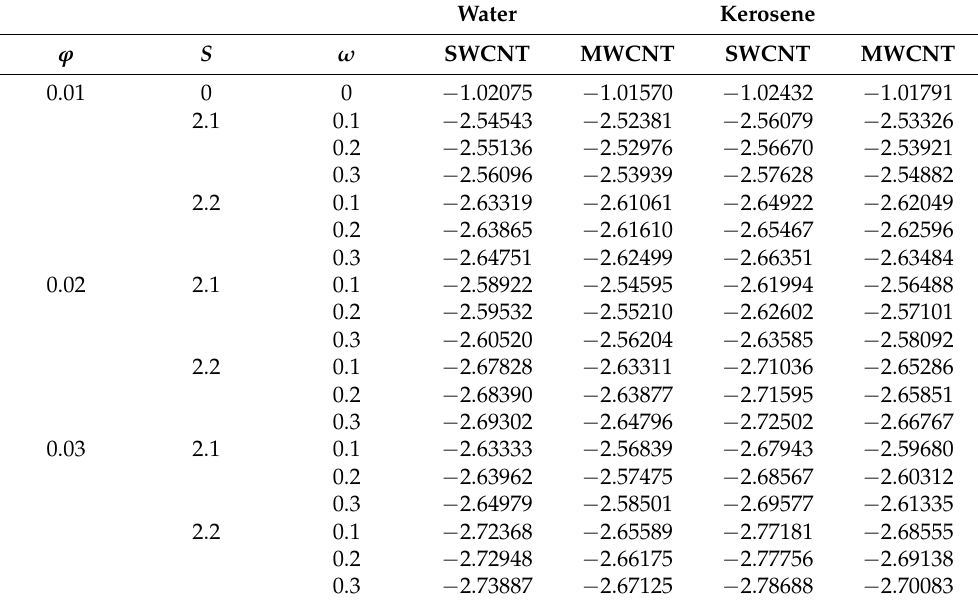
Figure 14. Temperature profiles θ ( η ) for some values of S . Table 3. Values of Re 1/2 x C fx for different values of ϕ , S , and ω when ε = 1.0 (stretching case) for both water and kerosene base fluids.